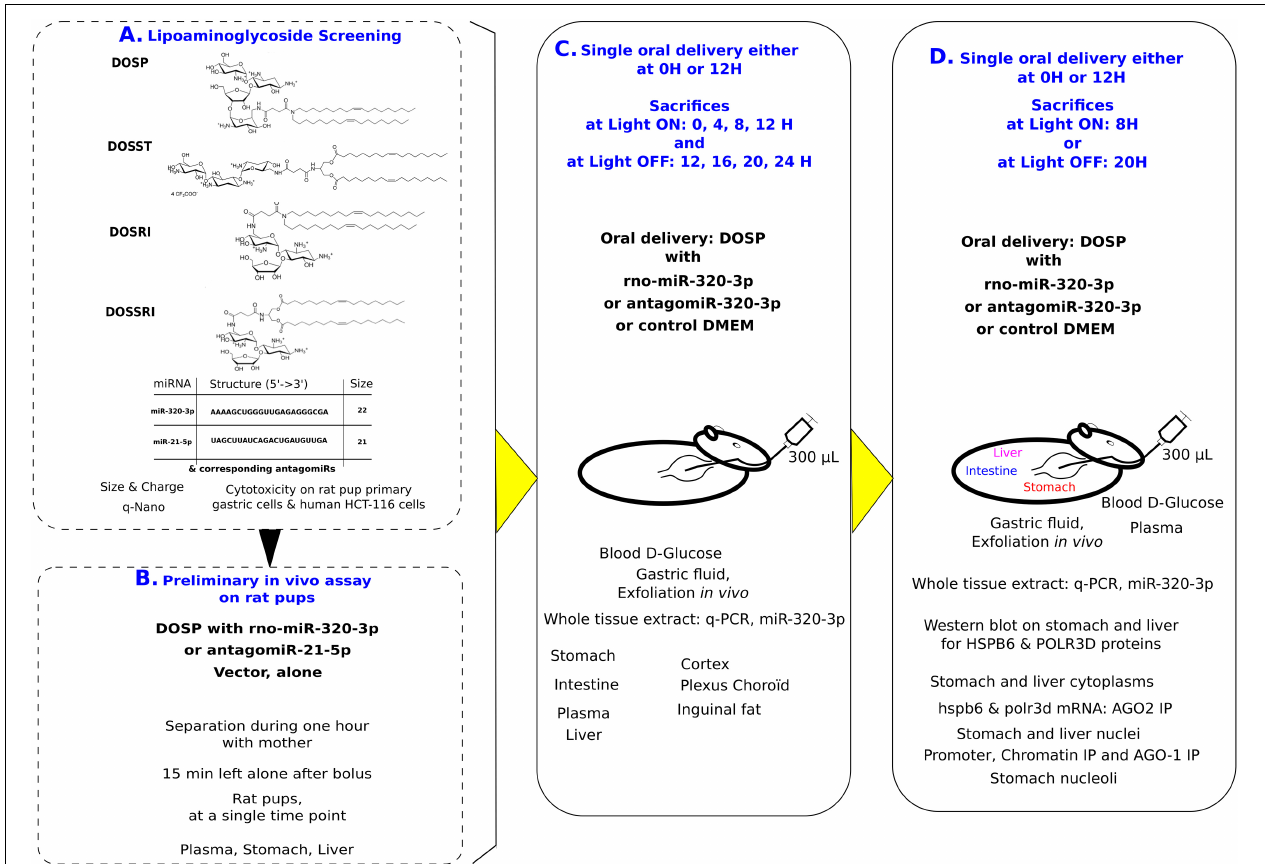
FIGURE 1 | Experimental design: First, we have selected on lack of cytotoxicity and nanoparticle properties, the best vehicle out of four molecules (A) . Second, we have selected conditions for in vivo oral bolus (B) . Third, we realized two experiments with time series over 12 h at light on or off, with miR-320-3p or its antagomiR embedded in dioleyl-succinyl-paromomycin (DOSP) and Control (C) . Finally, we have selected the time for inoculation maximizing detection of miR-320-3p to realize in vivo experiments according to circadian physiology and comparatively to antagomiR and control groups (D)